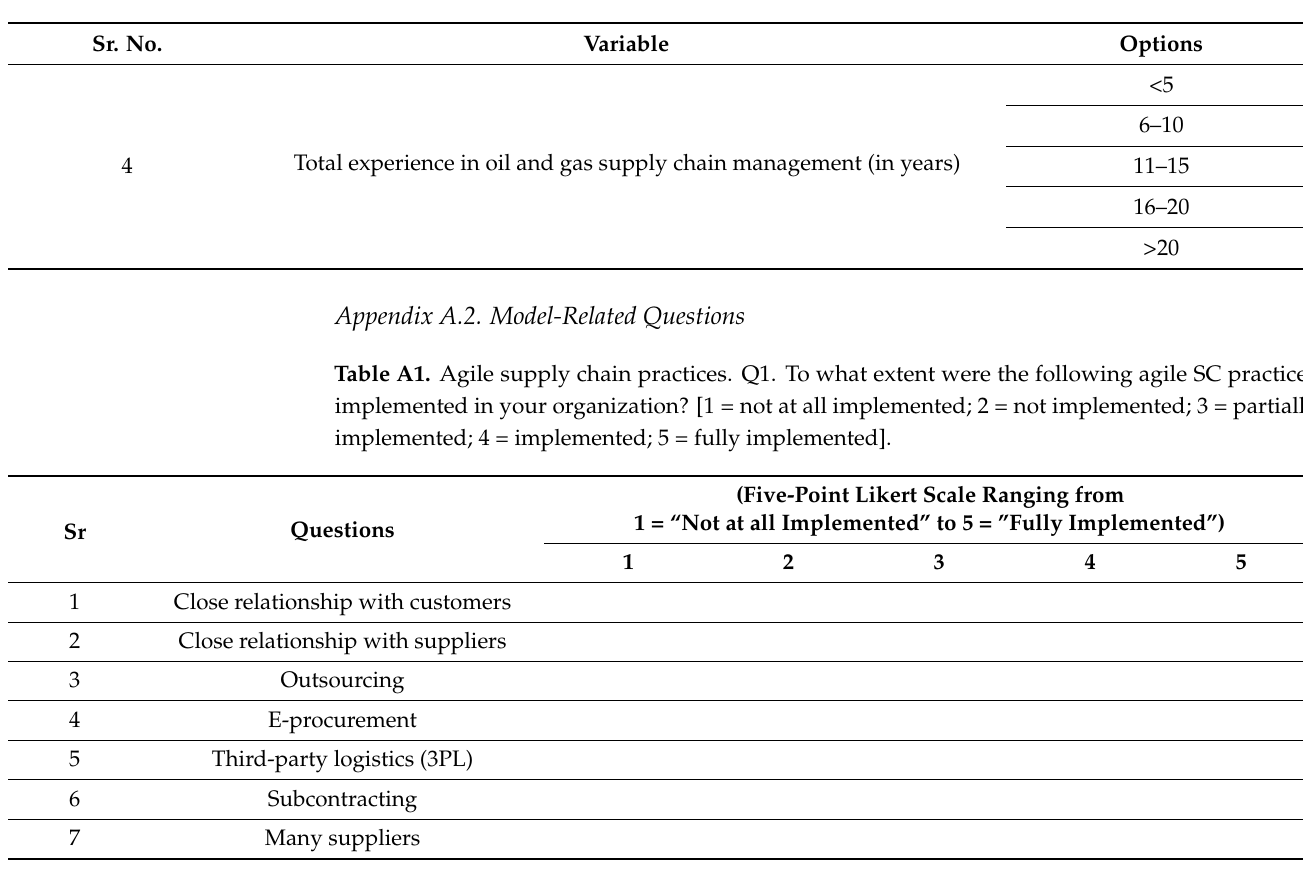
Table A2. Lean supply chain practices. Q2. To what extent were the following lean SC practices